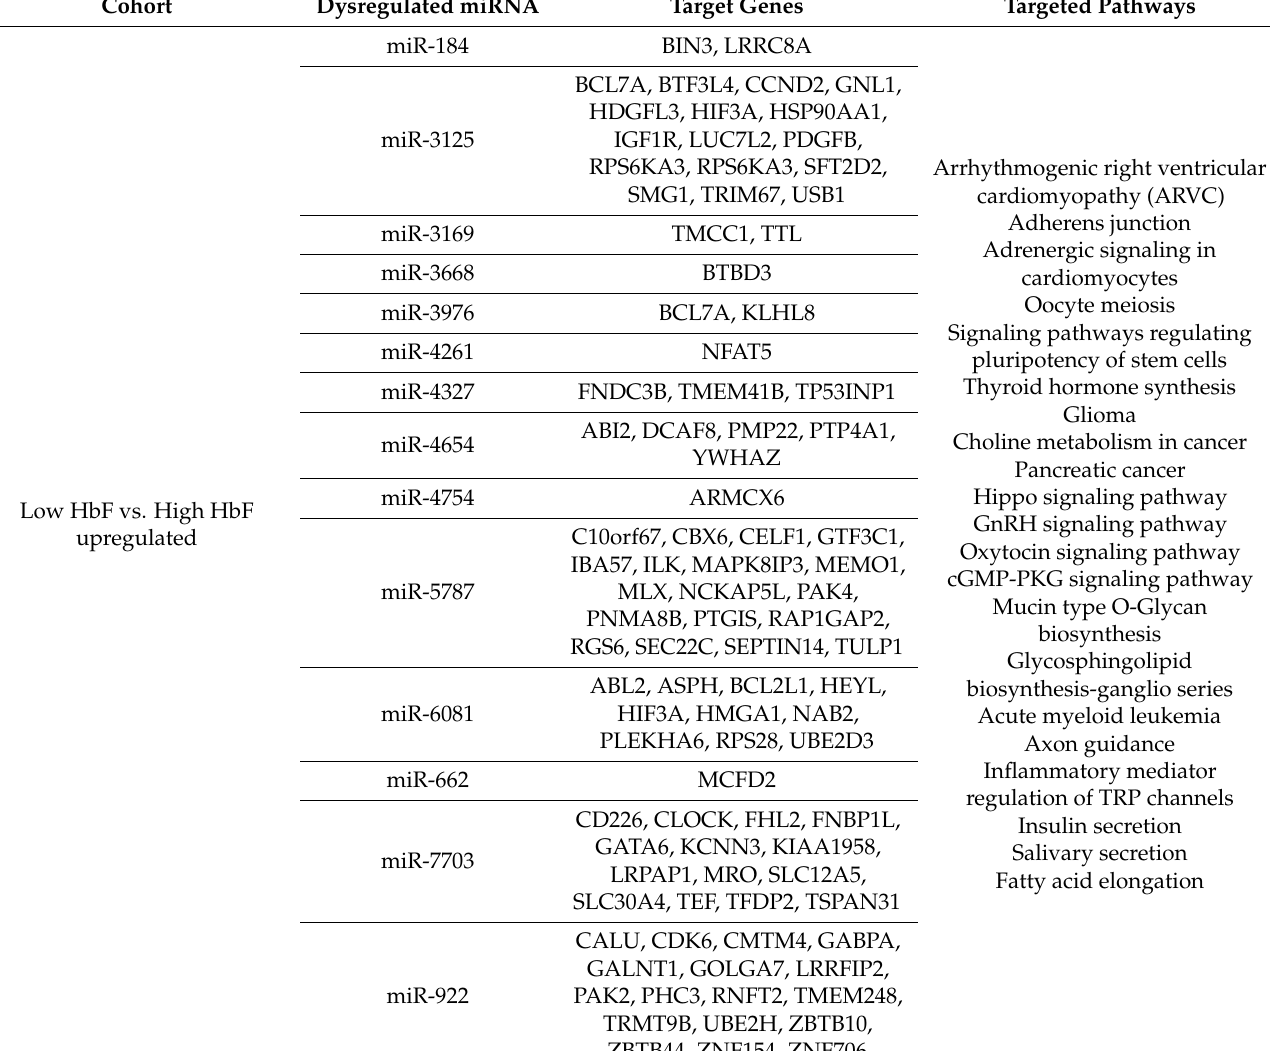
Table 2. Dysregulated miRNA, target gene interaction and associated